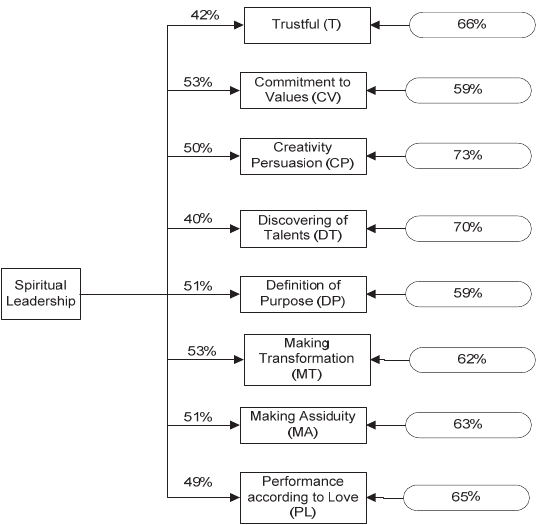
Fig. 2. Factor Analysis Model of hidden variable named Spiritual Leadership (The first indicator of